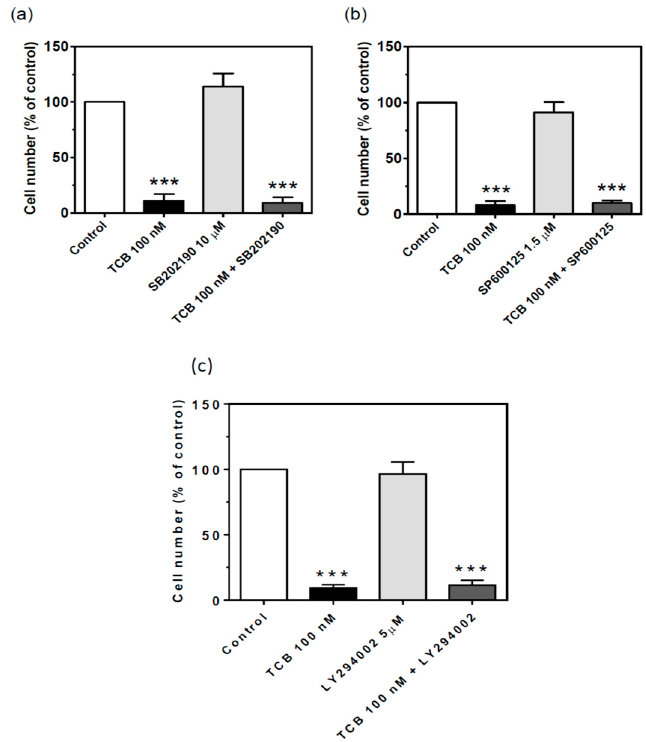
Figure 11. Effect of p38, JNK1/2 and PI3K inhibition on cell proliferation of LLC-PK1 cells treated with telocinobufagin (TCB). Serum-starved LLC-PK1 cells were treated with 100 nM TCB in 2.5% FBS for 72 h with or without 10 µ M SB202180 (p38 inhibitor) ( a ), 1.5 µ M SB600125 (JNK1/2 inhibitor) ( b ), or 5 µ M LY294002 (PI3K inhibitor) ( c ). Trypan blue-free viable cells were counted in Neubauer chamber. Data are the mean ± SEM of at least three independent experiments in duplicate. *** p < 0.005 vs. control.